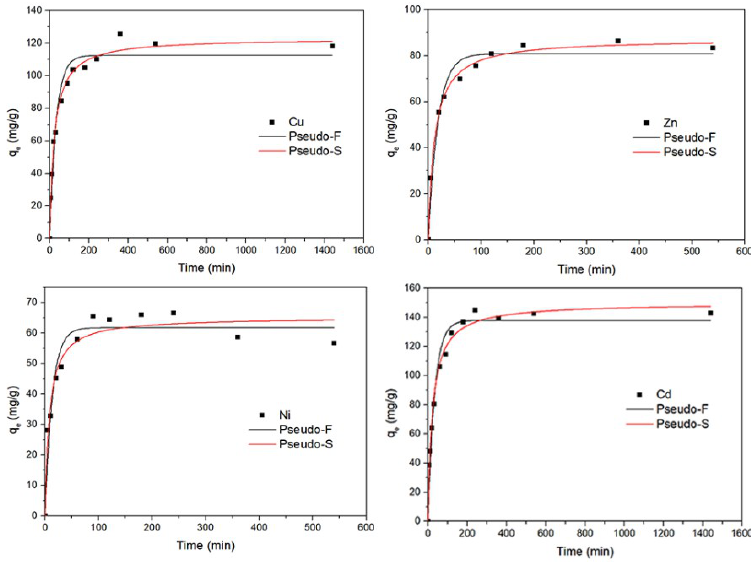
Figure 3. Kinetic adsorption plots of Cu(II), Zn(II), Ni(II) and Cd(II) by CA beads, respectively.